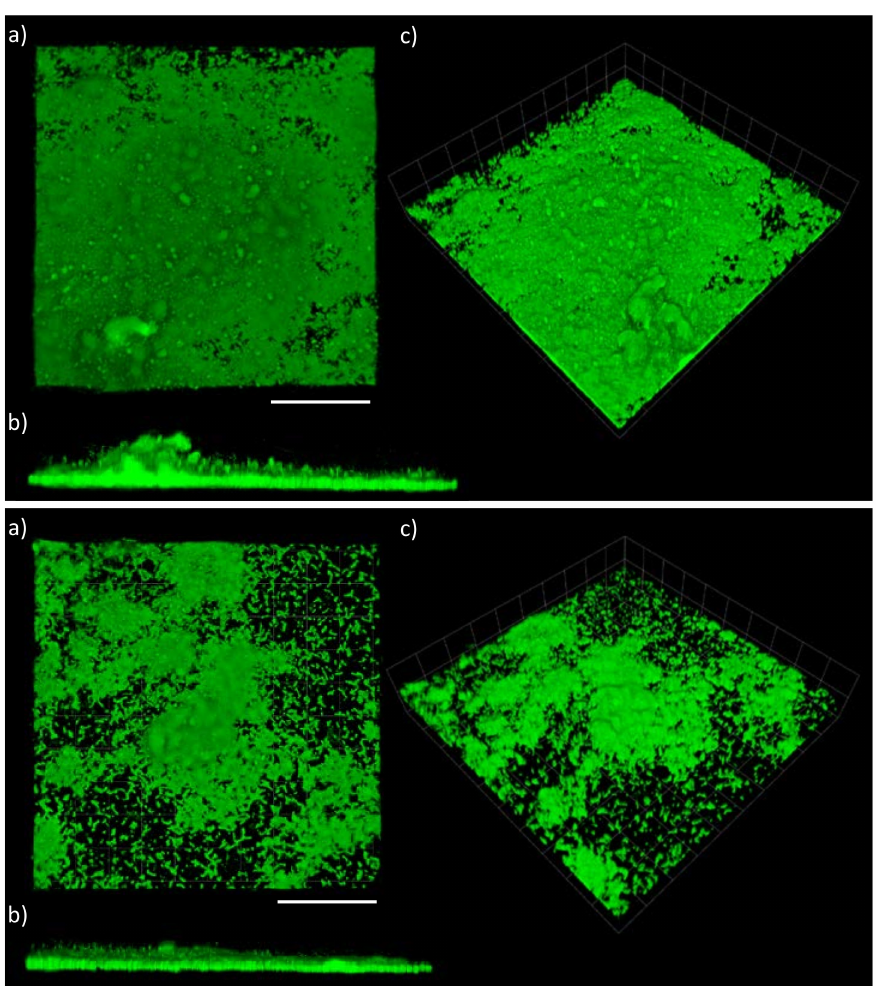
Figure 6. CLSM microscopy on LIVE/DEAD stained C. marina on the coated surfaces at the end-point (48 h), where ( Top ): PMMA + ROS, ( Bottom ): PMMA and ( a ) top view, ( b ) side view and ( c ) 3D view. Scale bars = 112 µ m. PMMA = poly(methyl methacrylate), ROS =